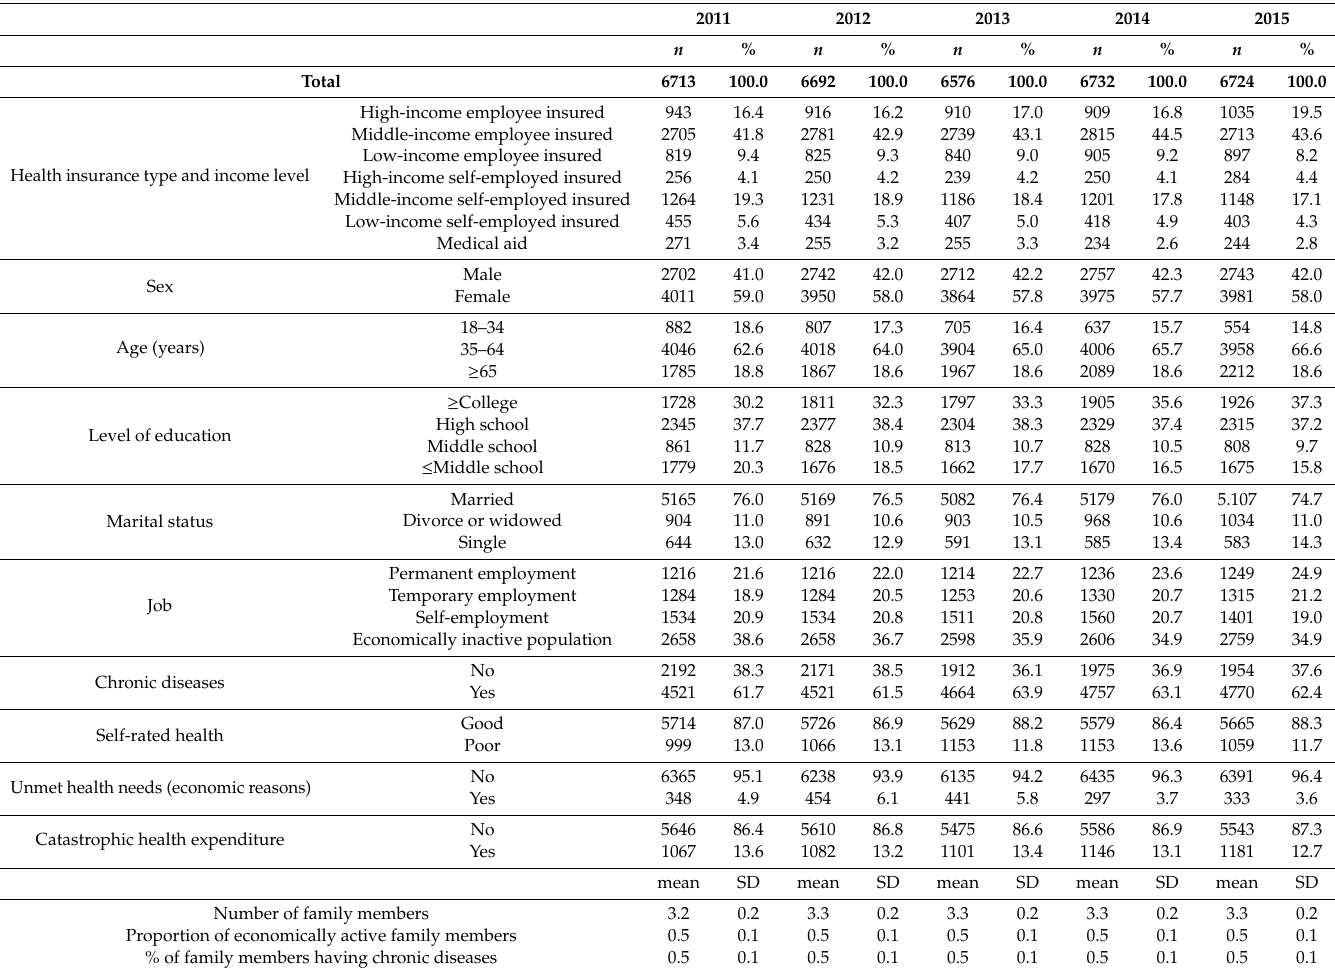
Table 1. General characteristics of the study population from 2011 to